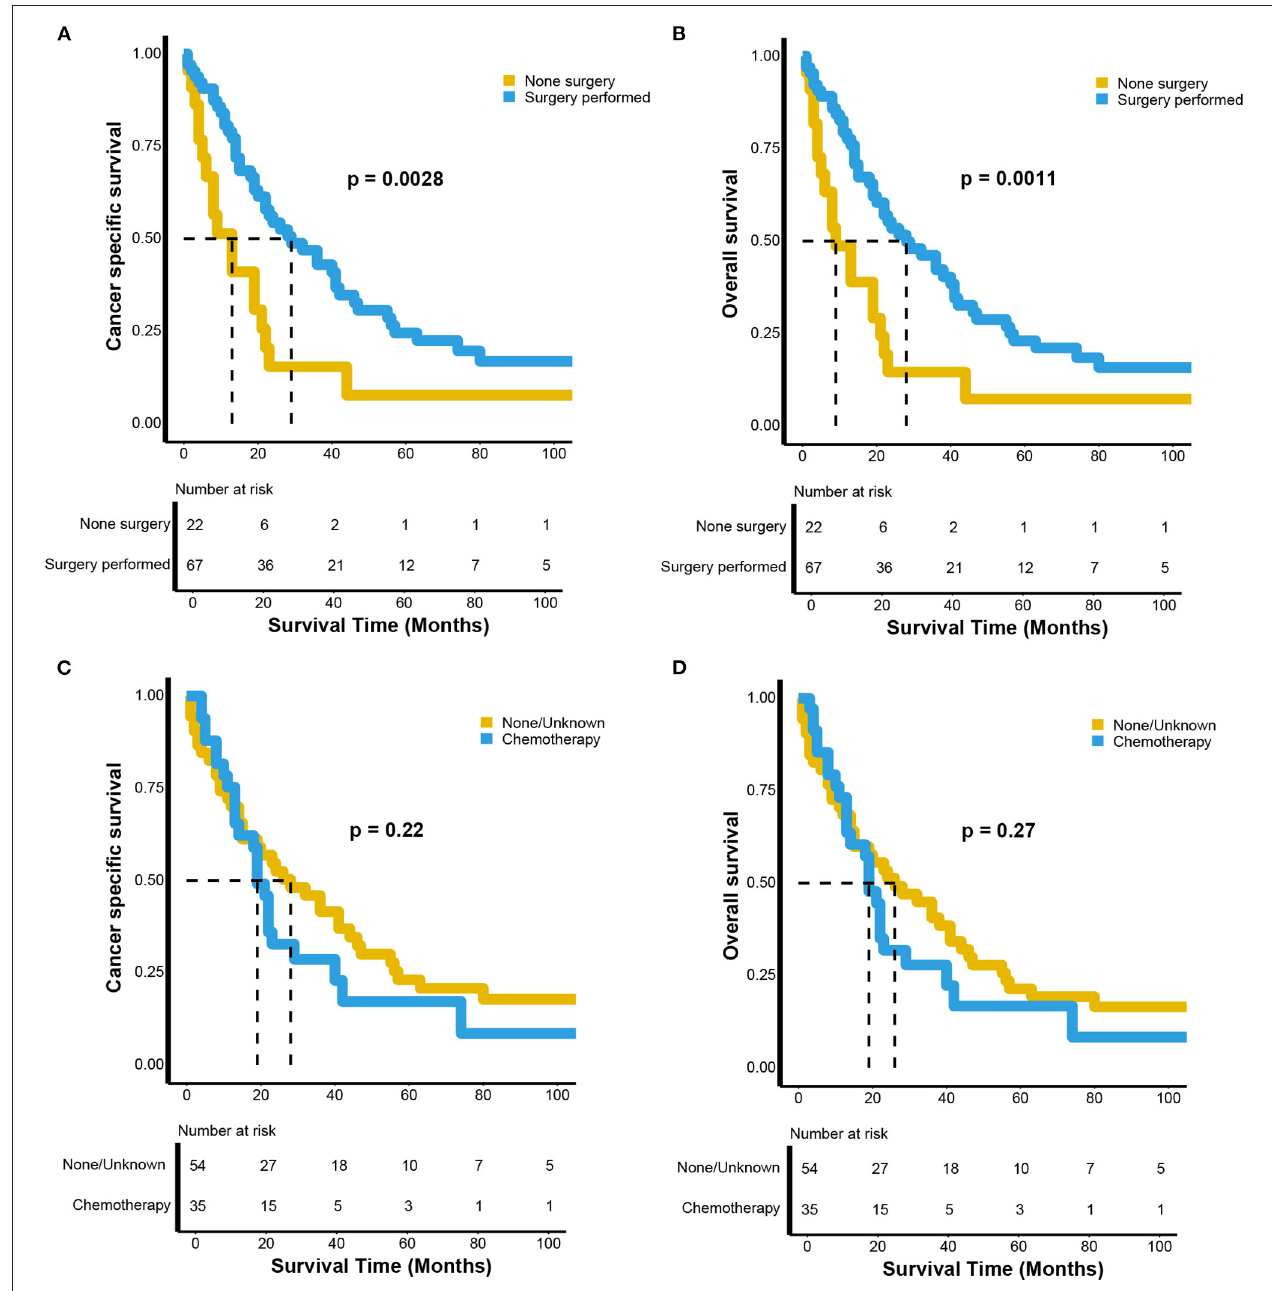
FIGURE 3 | Kaplan–Meier estimates of the (A) cancer-specific and (B) overall survival between the patients with advanced renal leiomyosarcoma receiving surgery or not; the (C) cancer-specific and (D) overall survival between the patients with advanced renal leiomyosarcoma receiving chemotherapy or not.